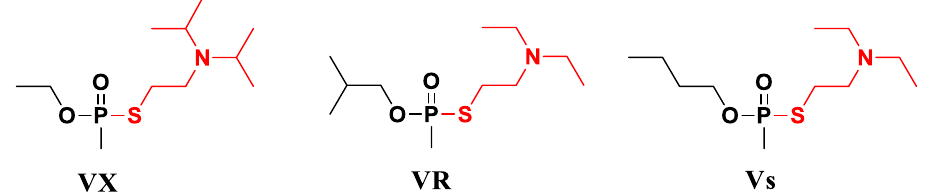
Figure 1. Structures of V-type OPNAs. Alkoxy phosphonic acid group is in black, and leaving group is in red.